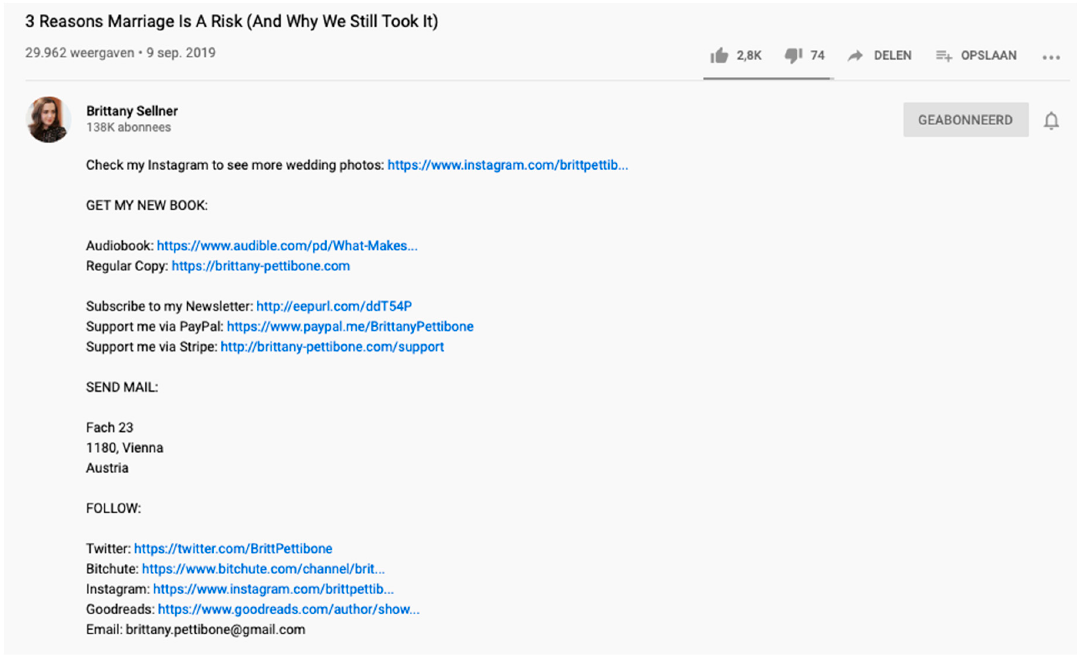
Figure 10. Hypermediacy and activism.